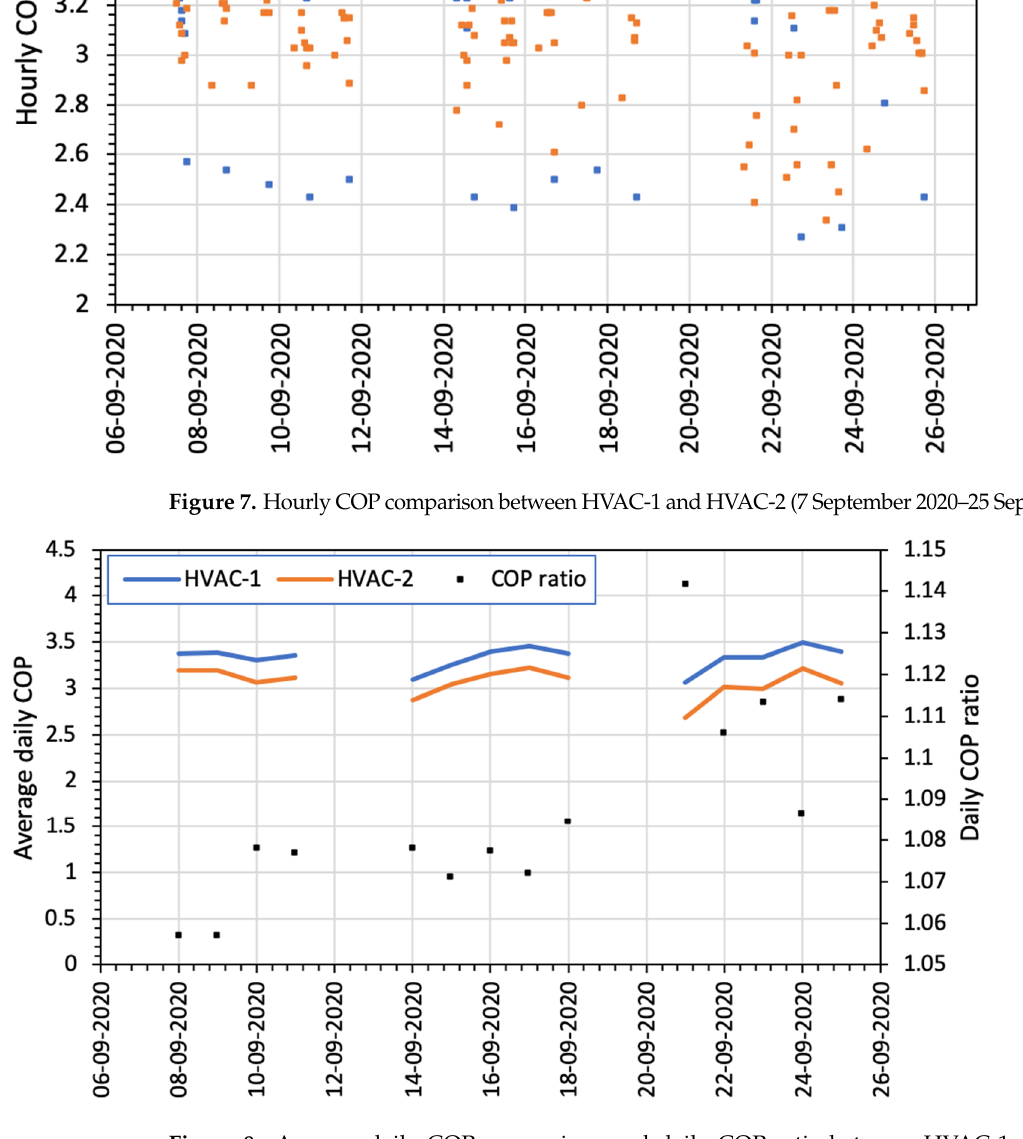
Figure 8. Average daily COP comparison and daily COP ratio between HVAC-1 and HVAC-2 (7 September 2020–25 September